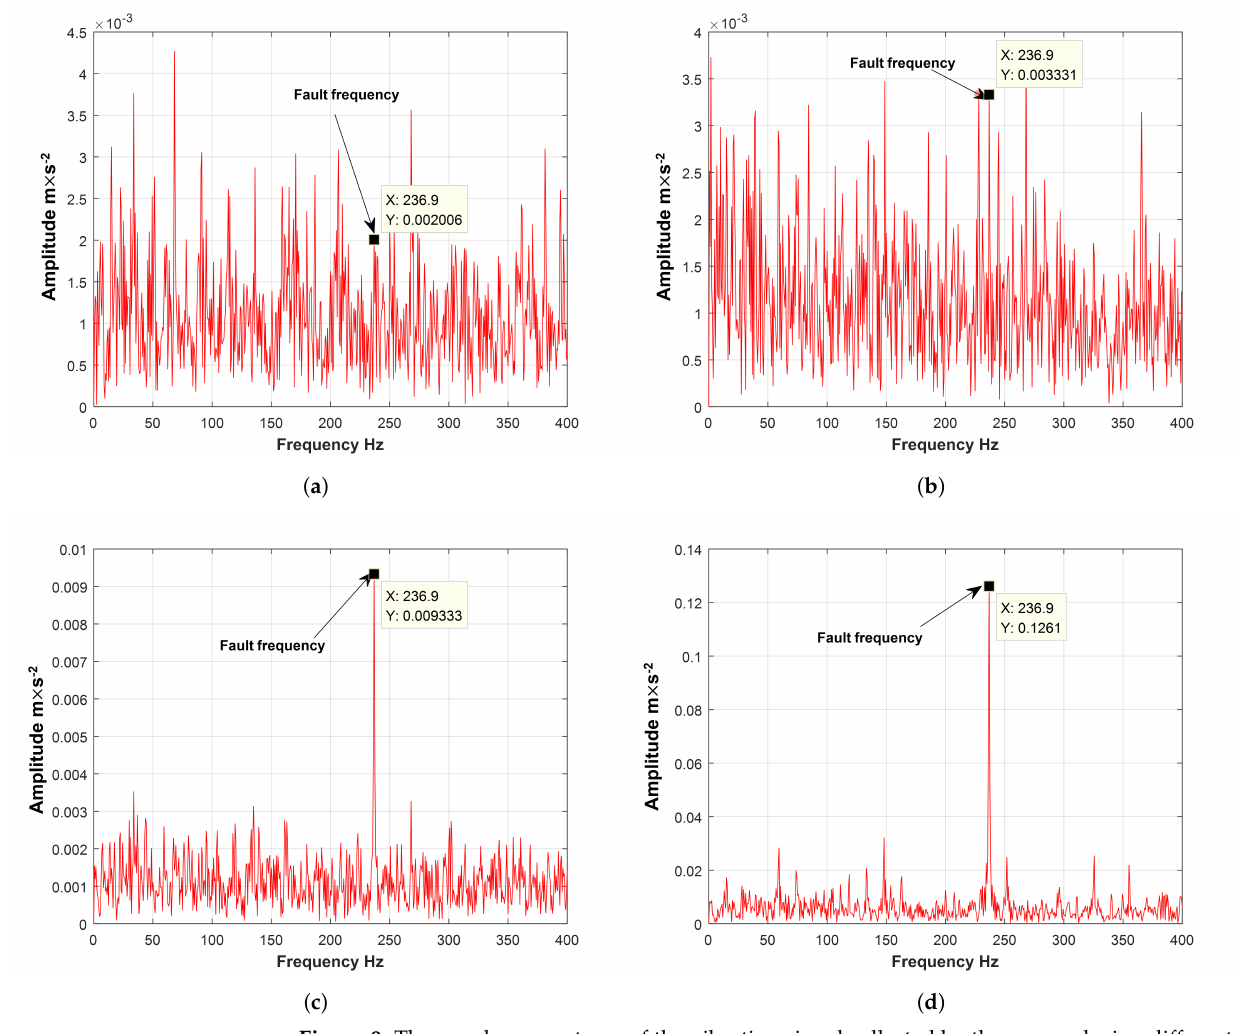
Figure 9. The envelope spectrum of the vibration signal collected by the sensor during different peri- ods. ( a ) Envelope spectrum for a bearing running at 14,690 min. ( b ) Envelope spectrum for a bearing running at 15,710 min. ( c ) Envelope spectrum for a bearing running at 15,720 min. ( d ) Envelope spectrum for a bearing running at 18,200